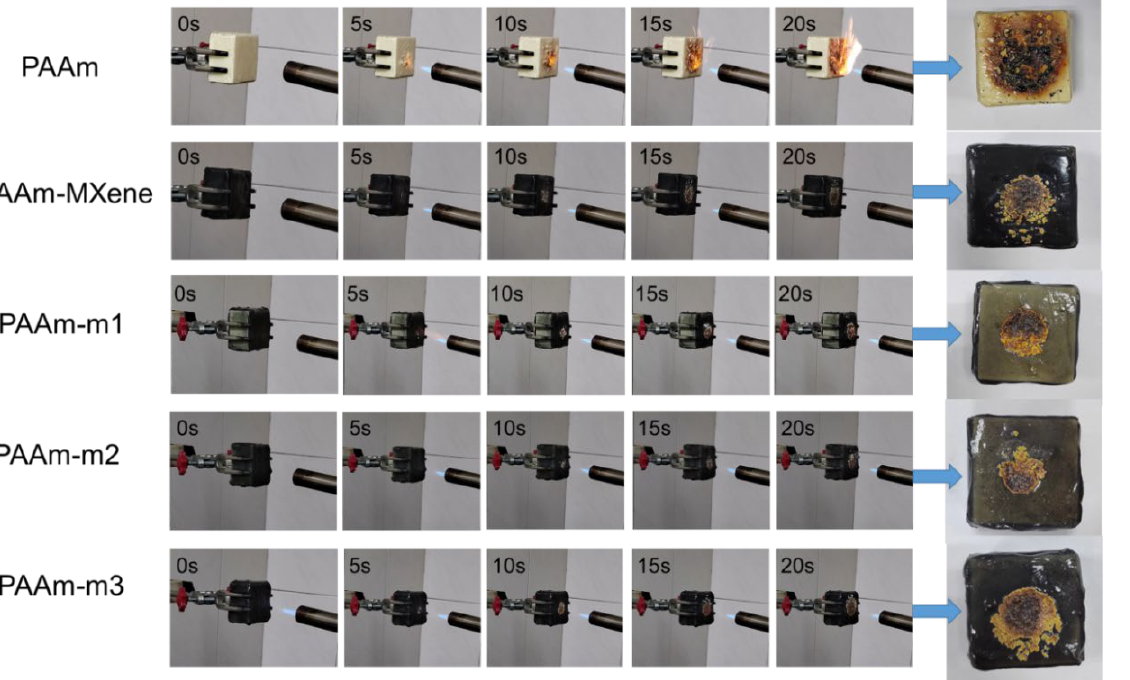
Figure 8. Optical photos of pure RPUF and Coated RPUF samples in the open flame combustion test.